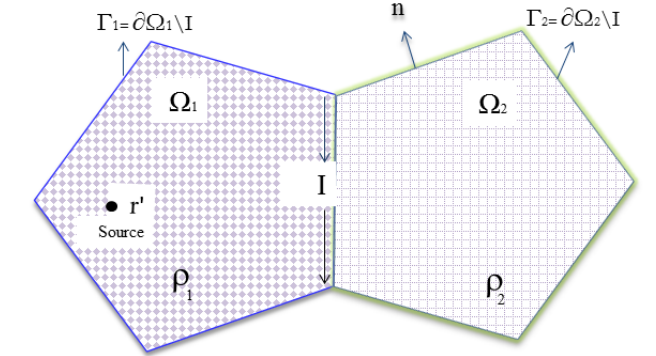
Fig. 1. Geometric configuration of the coupled